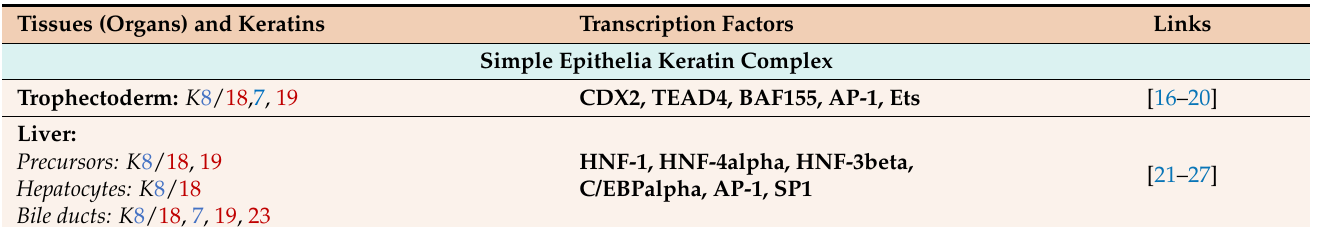
Table 1. The pattern of keratin expression and TFss involved in keratin expression regulation. *—absent in the mouse genome. ORS—outer root sheath, IRS—inner root sheath. Tissues (Organs) and